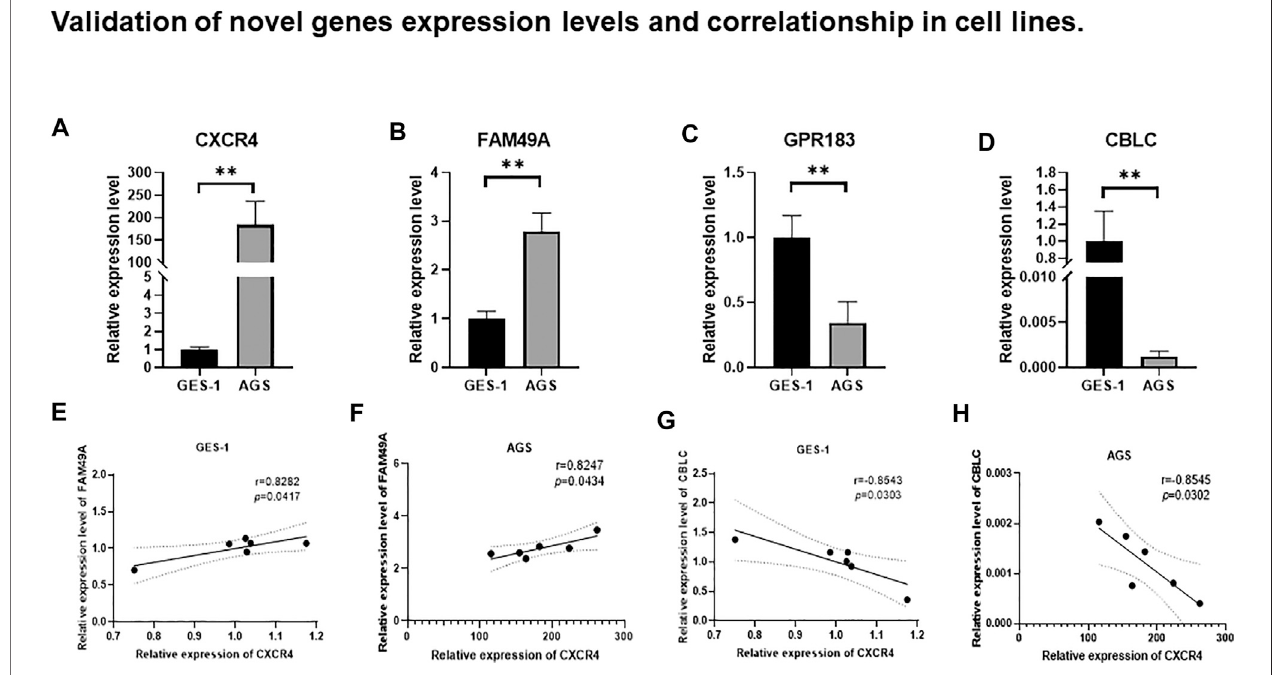
FIGURE8| Relativeexpression levelsof (A) CXCR4, (B) FAM49A, (C) GPR183,and (D) CBLCbetweenAGSandGES-1.ns: notsigni fi cant;* p < 0.05;** p < 0.01; *** p < 0.001; **** p < 0.0001. Correlation between CXCR4 and FAM49A in GES-1 (E) and AGS (F) . Correlation between CXCR4 and CBLC in GES-1 (G) and AGS (H) .